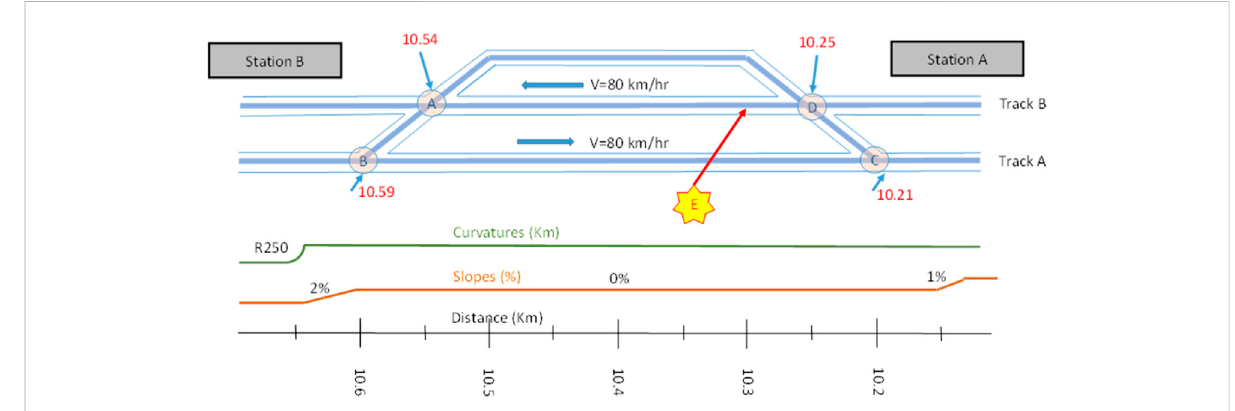
FIGURE 9 Track diagram in the area where the failure occurred (Point E).